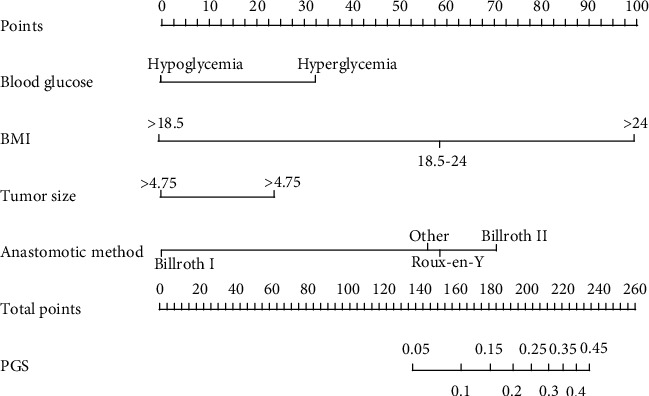
Developed nomogram.